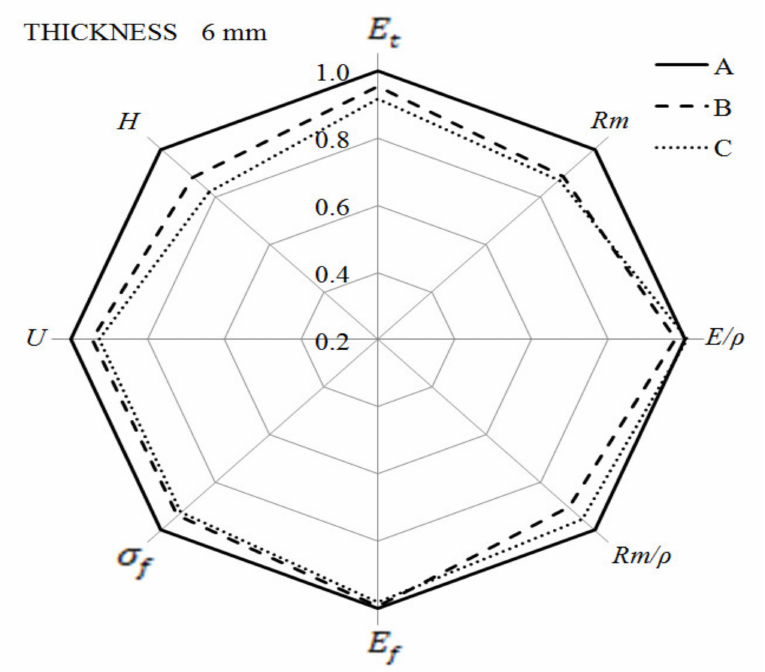
Figure 29. Changes in mechanical properties of 6.0 mm thick foamed samples as compared to solid PA66 GF30 moldings.